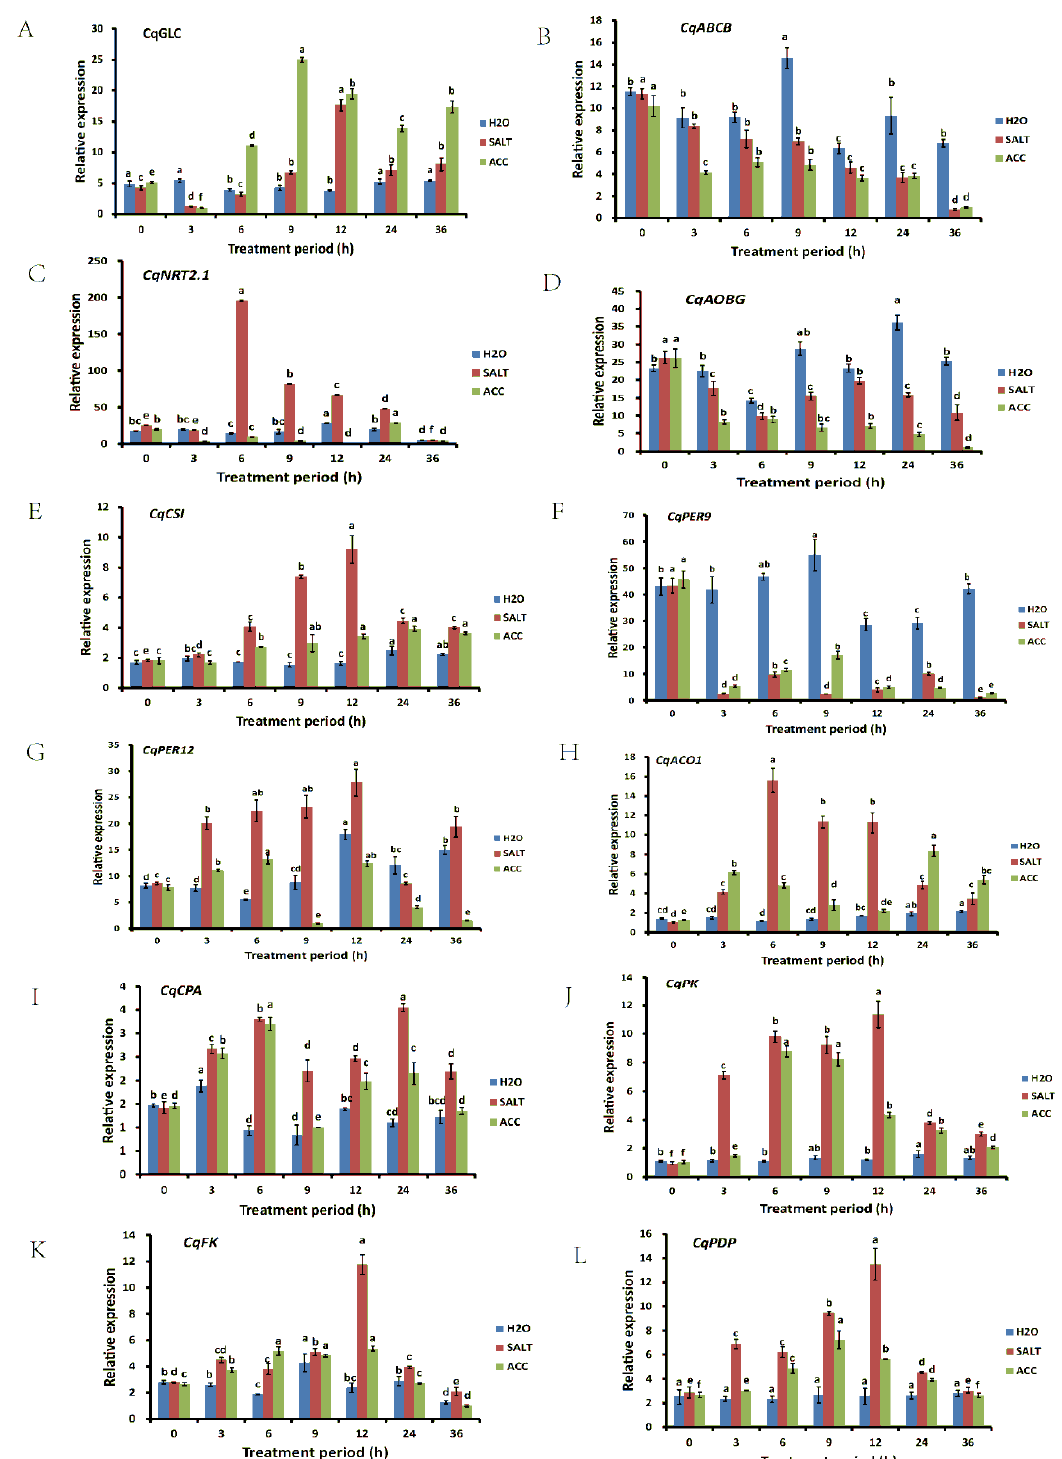
Figure 4. Gene expression verification by qRT-PCR. The expressions of CqGLC (A), CqABCB (B), CqNRT2.1 (C), CqAOBG (D), CqCSI (E), CqPER9 (F), CqPER12 (G), CqACO1 (H), CqCPA (I), CqPK (J), CqFK (K), and CqPDP (L) were detected under different treatments with different treatment periods. The differences between samples at different treatment periods were analyzed, and the statistical significance of the difference was confirmed by ANOVA at α = 0.05 level.